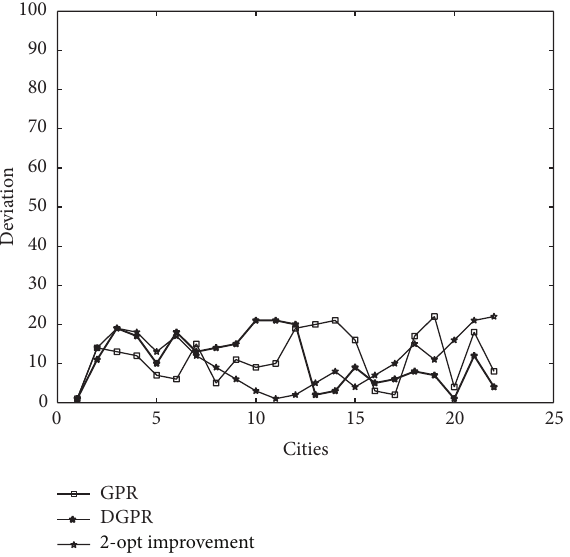
Figure 6: DGPR maintains superiority when juxtaposed with GPR and local